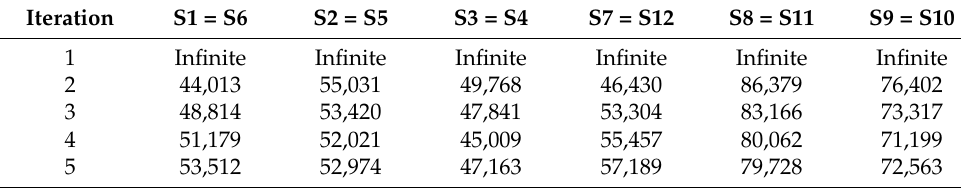
Table 2. Spring stiffness evolution in the FEM model (kN/m).